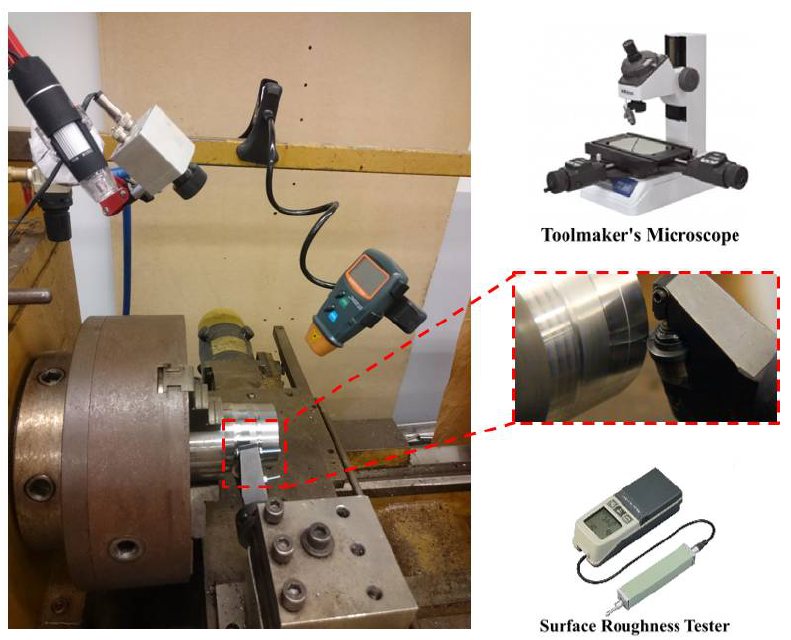
Figure 2. Experimental setup for the turning process using a self-propelled rotary tool. The feed rate, cutting speed, and inclination angle were selected as design variables, while the average surface roughness and flank tool wear were chosen to be performance indicators. The average surface roughness was used to evaluate the machined surface quality. The arithmetical mean deviation of the assessed profile ( Ra ) was measured using Mitutoyo (SJ.201) portable surface roughness at a cut-off length of 2.5 mm. The surface lated and used for the analysis. Mitutoya toolmaker’s microscope (TM-A505B) was used to measure the average flank wear of the insert after each run. The flank tool wear was measured at four different locations on the circular flank face of the insert, and the average value was obtained and used in the analysis. Figure 3 shows a flow chart for the experimental procedures.